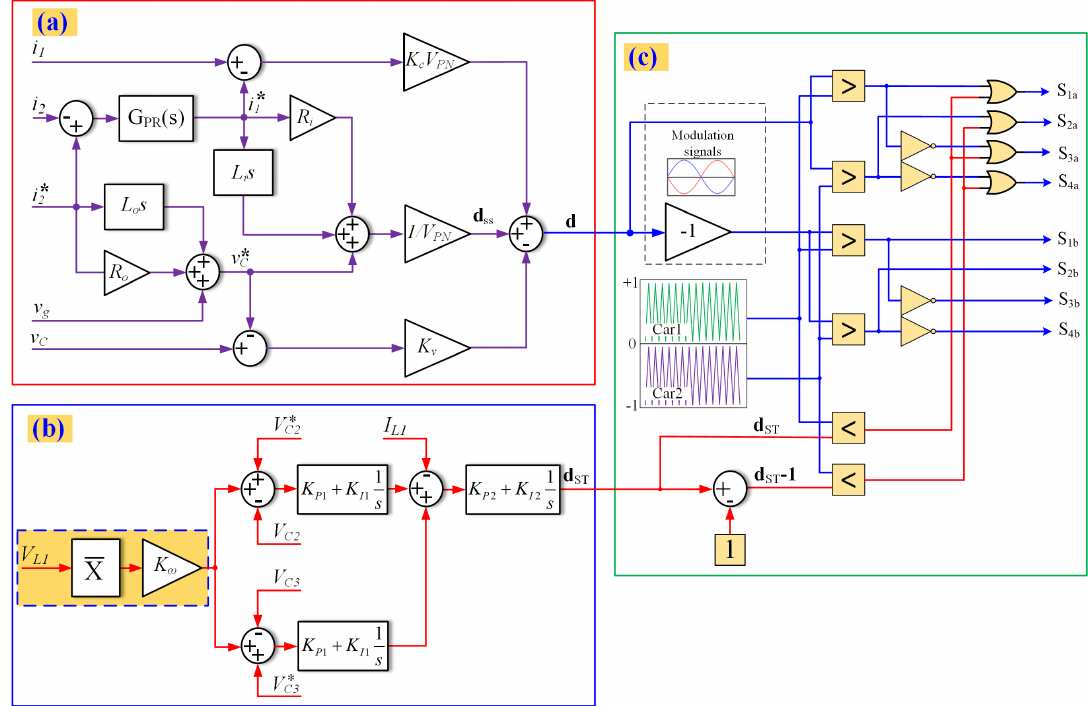
Figure 3. The block diagram of the developed control technique; ( a ) Lyapunov-function based control for ac-side variables; ( b ) dc-side control with 2 ω ripple suppression; ( c ) Gate signal